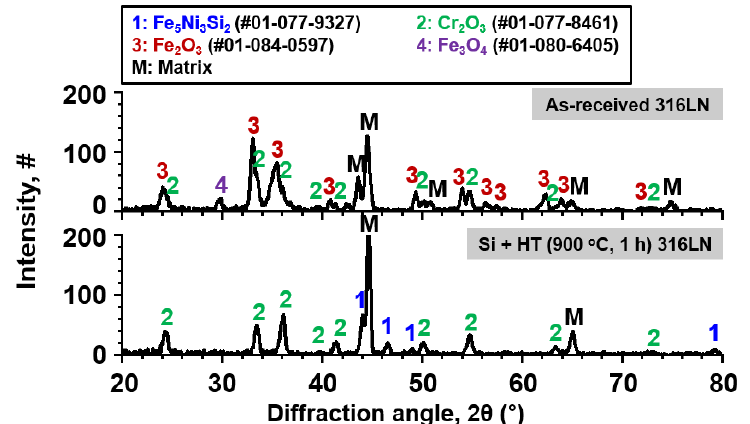
Figure 4. Result of XRD analysis conducted on the as-received and surface-modified SS 316LN after exposure to S-CO 2 at 650 °C (20 MPa) for 500 h.